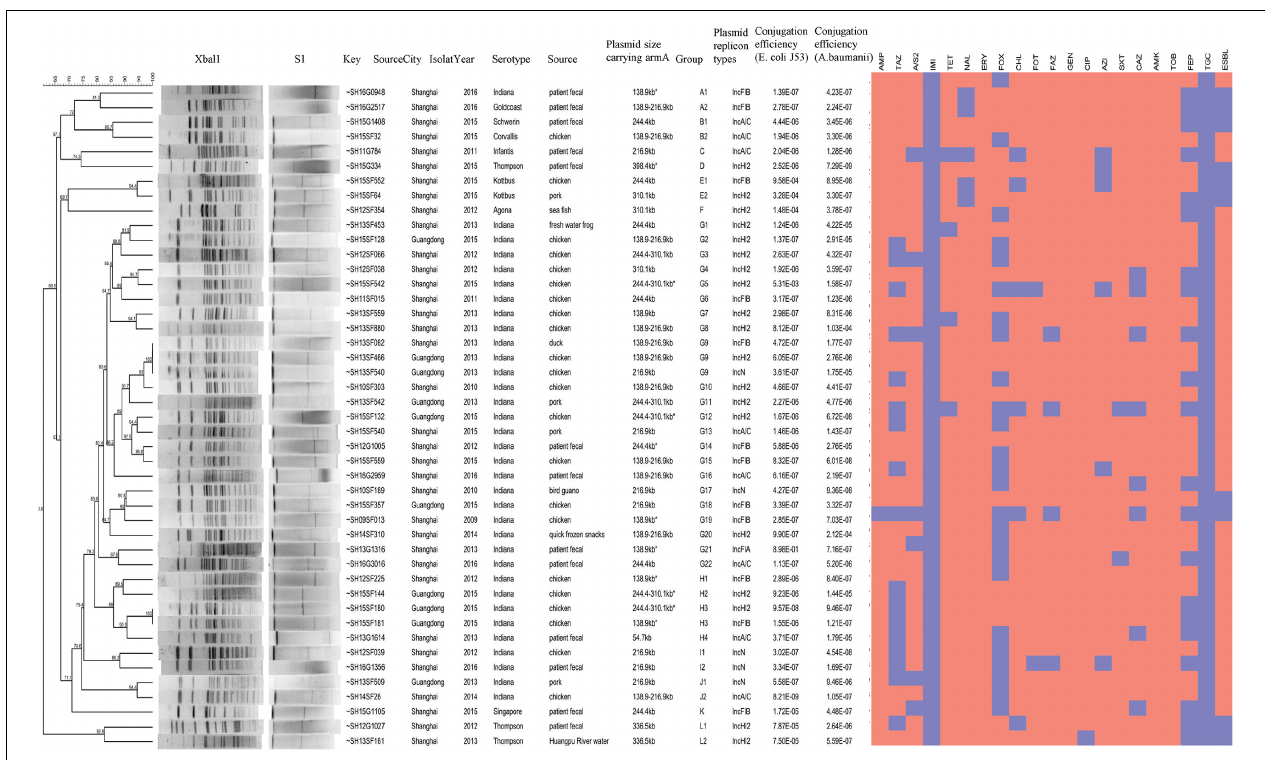
FIGURE 1 | Generated dendrograms showing the cluster analysis of Xba I-digested PFGE patterns of the armA -harboring Salmonella strains isolated in this study.